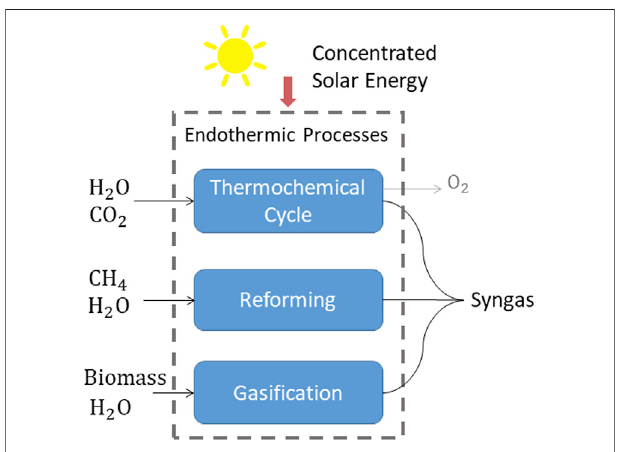
FIGURE 1 | Main process routes for the solar thermochemical productionofsyngas − amixtureofH 2 andCOthatcanbefurtherprocessedto drop-in transportation